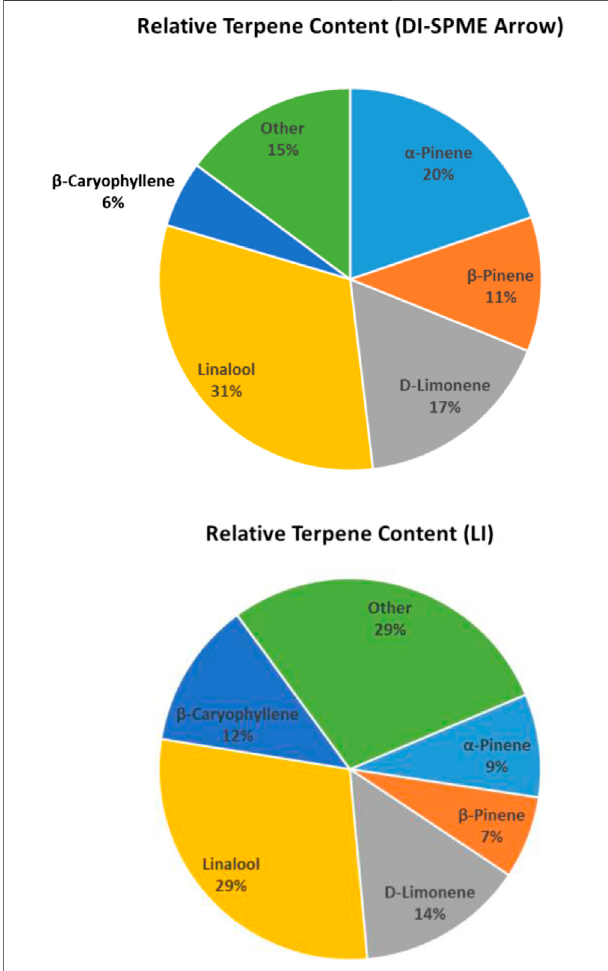
FIGURE 5 | Mint Chocolate Chip terpene pro fi les determined by DI- SPME Arrow and